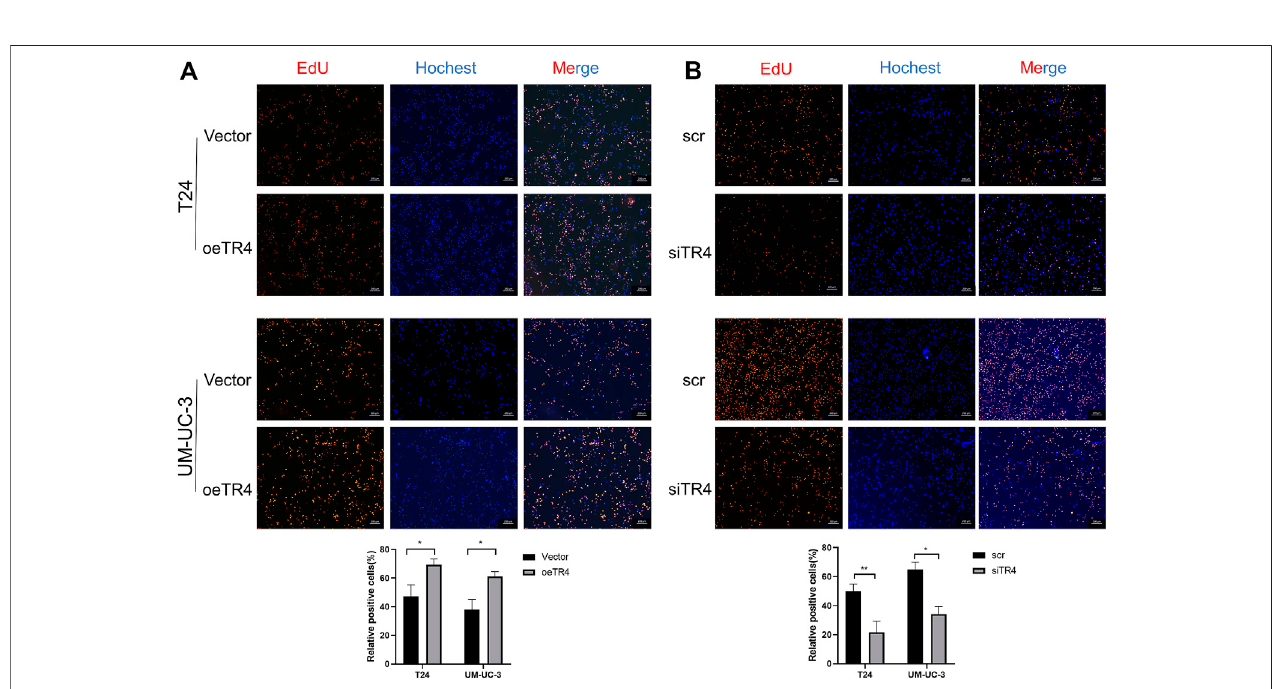
FIGURE 3 | Effect of TR4 on viability in BC cell lines: (A) After transfecting Vector and TR4 in BC cell lines, the proliferation ability was measured by the EdU assay. Quanti fi cation of positive cells was determined by microscopy with × 40 magni fi cation in three randomly chosen fi elds. Data are presented as mean ± SD. * p < 0.01. (B) After transfecting scr and siTR4 in BC cell lines, quanti fi cation of positive cells was determined in three randomly chosen fi elds. * p < 0.05, ** p < 0.01.